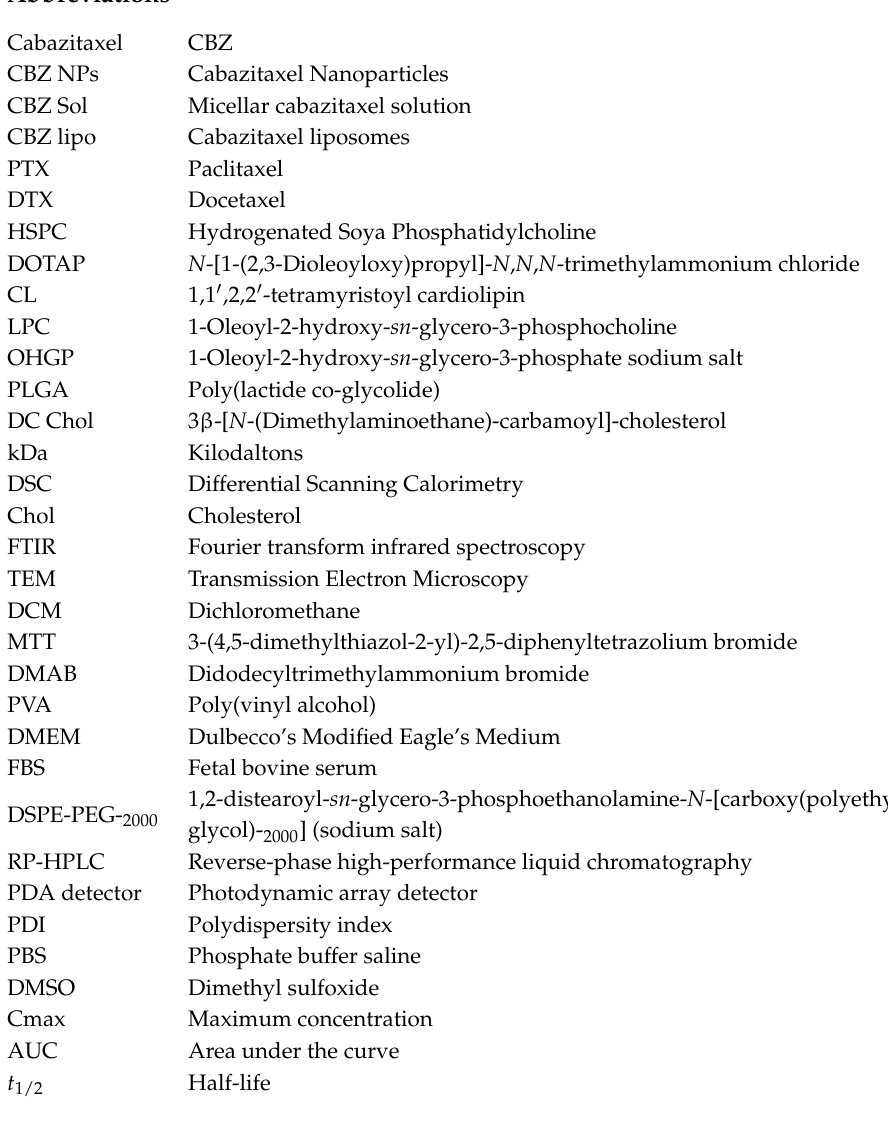
Figure S1. Cabazitaxel release kinetics from different formulations of CBZ Sol (cabazitaxel micellar solution), CBZ NPs (cabazitaxel nanoparticles), and CBZ Lipo (cabazitaxel liposomes): (A) zero-order model, (B) first-order model, (C) Higuchi model, and (D) Peppas